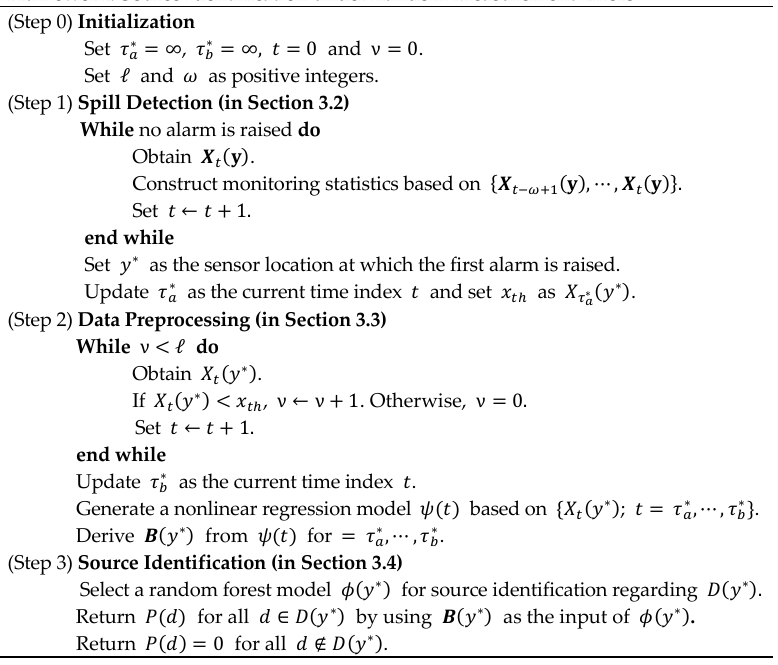
Figure 1. Overall description of the proposed source identification framework.